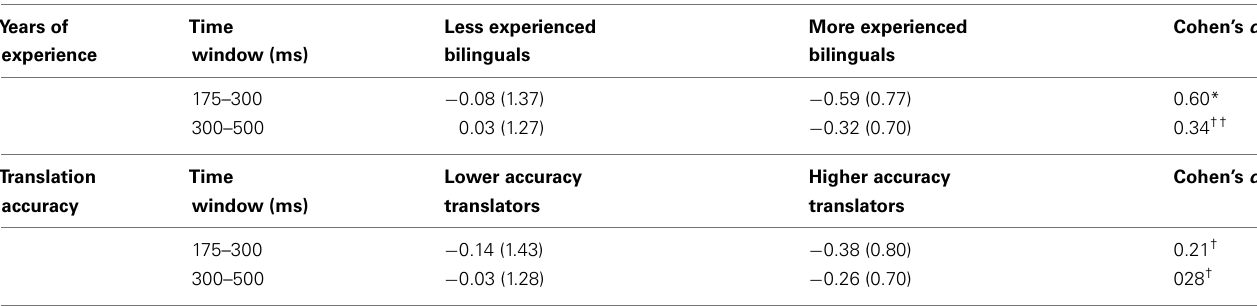
Table 2 | Cross-language ND effects for English targets in late bilinguals in terms of effect size (differences are in µ